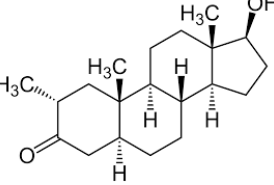
Figure 15. Chemical structure of drostanolone. Formula: C 20 H 32 O 2.